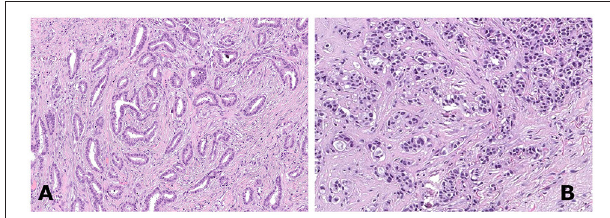
FIGURE 1 | A case of tubular breast carcinoma composed of well-differentiated rounded to angulated tubular structures organized haphazardly [ (A) , hematoxylin and eosin staining, 150 × ]. A case of invasive ductal carcinoma not otherwise specified (NOS), grade 1, demonstrating tumor cells arranged in clusters [ (B) , hematoxylin and eosin staining, 150 × ].